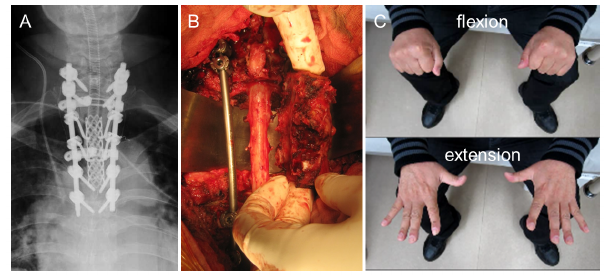
Figure 3. Case 1: A 49-year-old man with primary spinal tumor (angiosarcoma) at T2–4. A: Total en bloc spondylectomy (TES) was performed using a posterior-only approach. B: Bilateral T2–4 nerve roots were transected. C: No deterioration of upper-extremity motor function occurred after surgery.